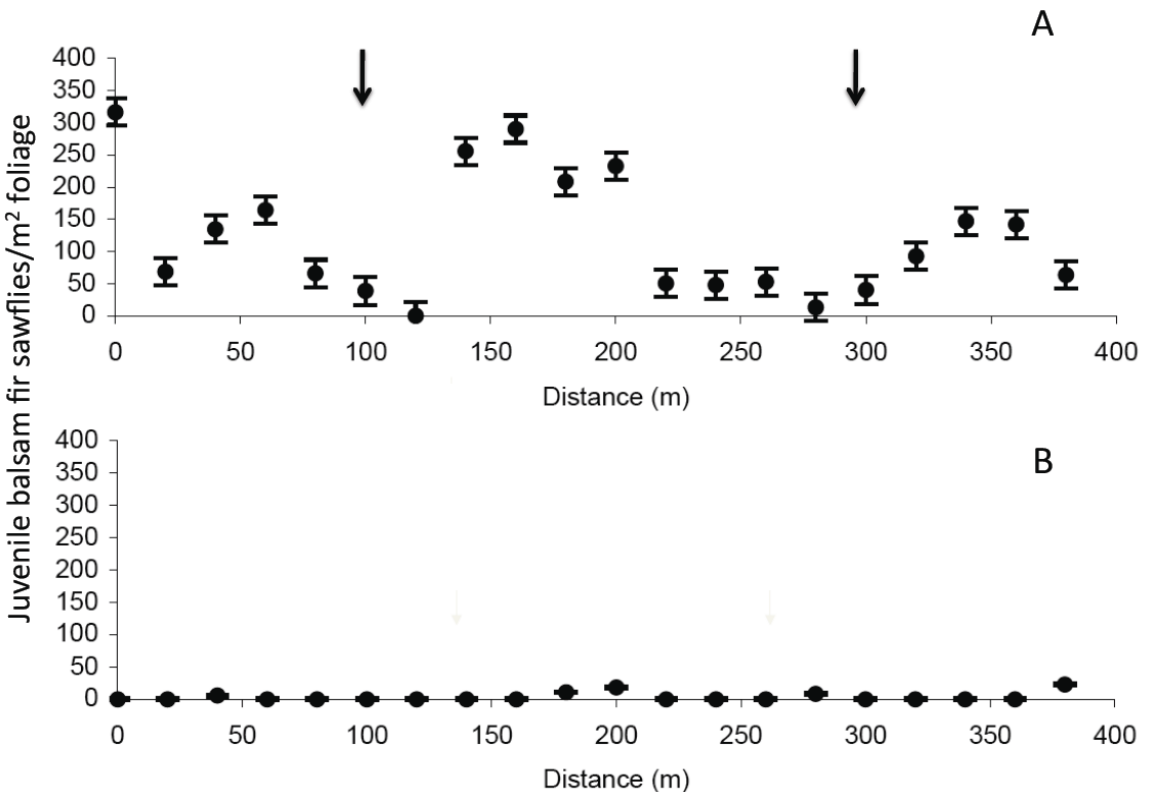
Figure 7. (cid:39)(cid:72)(cid:81)(cid:86)(cid:76)(cid:87)(cid:76)(cid:72)(cid:86)(cid:3)(cid:82)(cid:73)(cid:3)(cid:77)(cid:88)(cid:89)(cid:72)(cid:81)(cid:76)(cid:79)(cid:72)(cid:3)(cid:69)(cid:68)(cid:79)(cid:86)(cid:68)(cid:80)(cid:3)(cid:73)(cid:76)(cid:85)(cid:3)(cid:86)(cid:68)(cid:90)(cid:73)(cid:79)(cid:76)(cid:72)(cid:86)(cid:3)(cid:68)(cid:87)(cid:3)(cid:50)(cid:79)(cid:71)(cid:3)(cid:48)(cid:68)(cid:81)(cid:182)(cid:86)(cid:3)(cid:51)(cid:82)(cid:81)(cid:71)(cid:3)(cid:82)(cid:81)(cid:3)(cid:11) A ) 2 July and ( B ) 13 August 2003, 1 y after the aerial application of NeabNPV. The densities are represented as mean values (±SEM). Arrows indicate the approximate location of the original spray